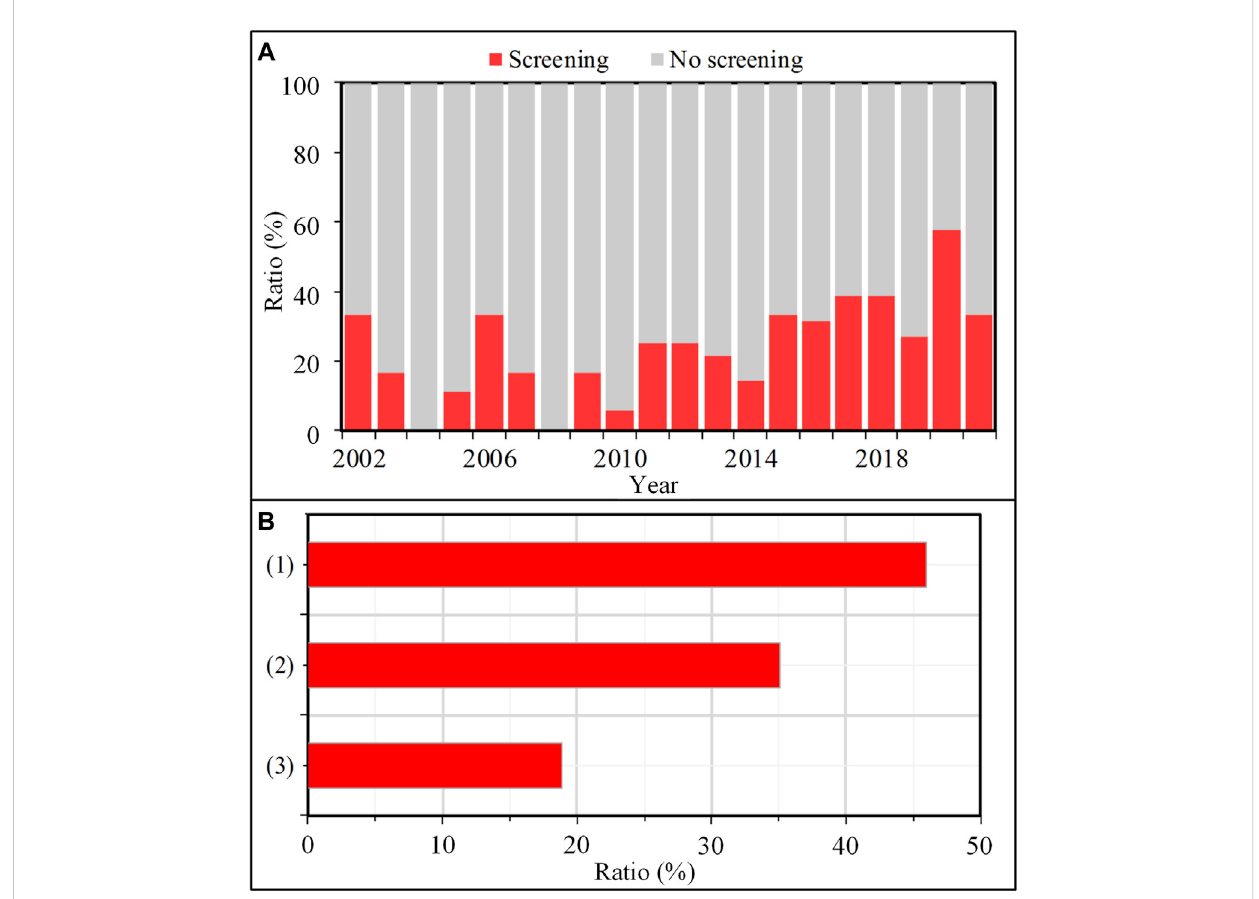
FIGURE 2 (A) Indicates the proportion of screening and non-screening. (B) Indicates the proportion of different screening